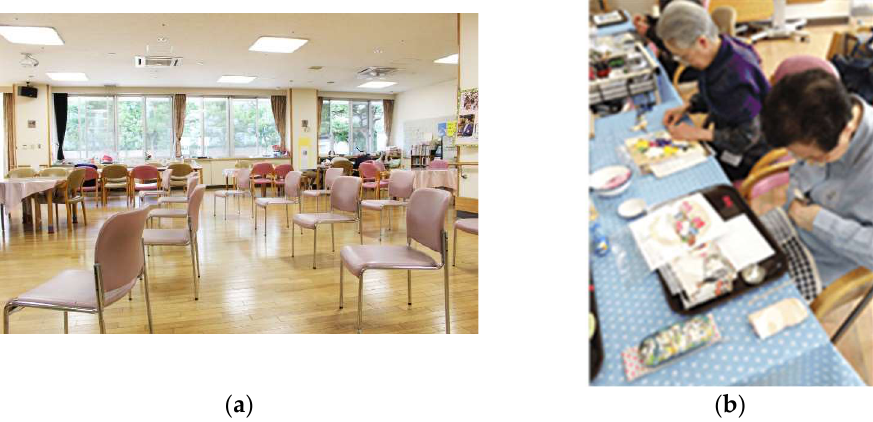
Figure 1. Photograph of ADC-X: ( a ) living and exercise space; ( b ) craft